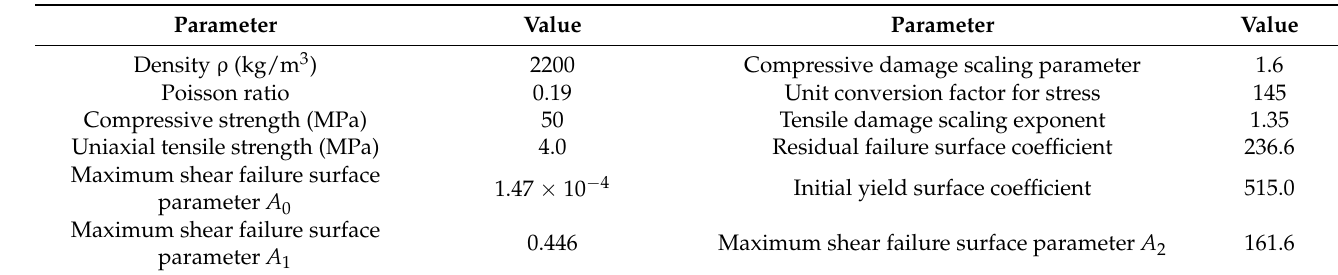
Table 1. Parameters of mortar.